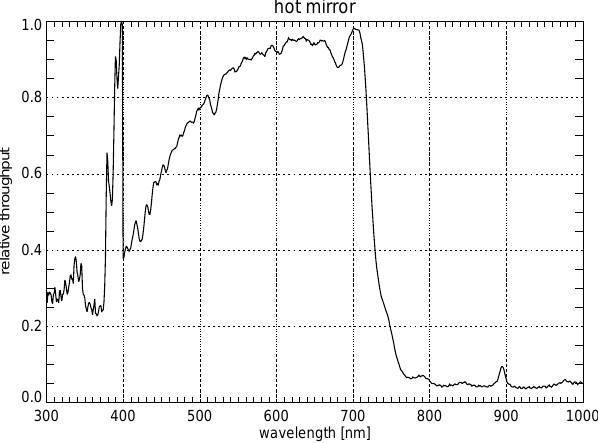
Figure 7. Transmission for infrared blocking filter (hot mirror) used in THEMIS and Rainbow cameras. Feature at 380–400nm is a cal- ibration artifact that does not significantly impact analysis